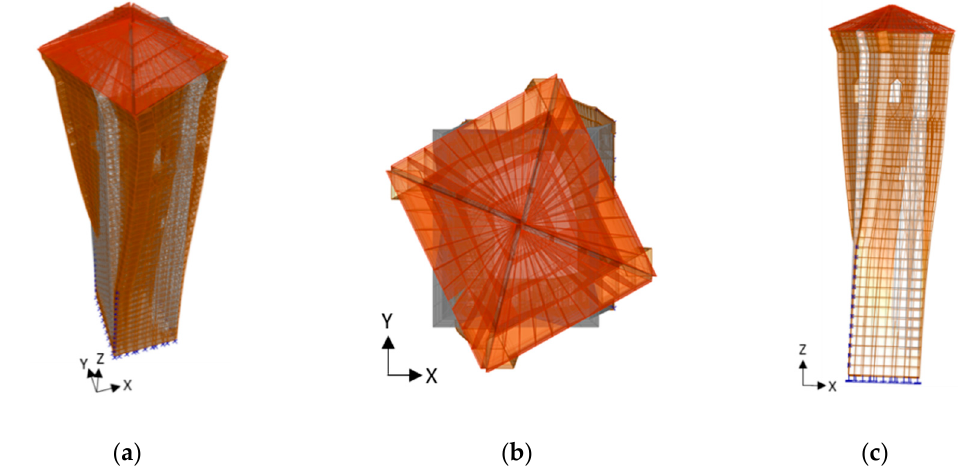
Figure 13. Second vibration mode shape of the tower (T = 0.666 s): ( a ) 3D view; ( b ) top view; ( c ) front view.